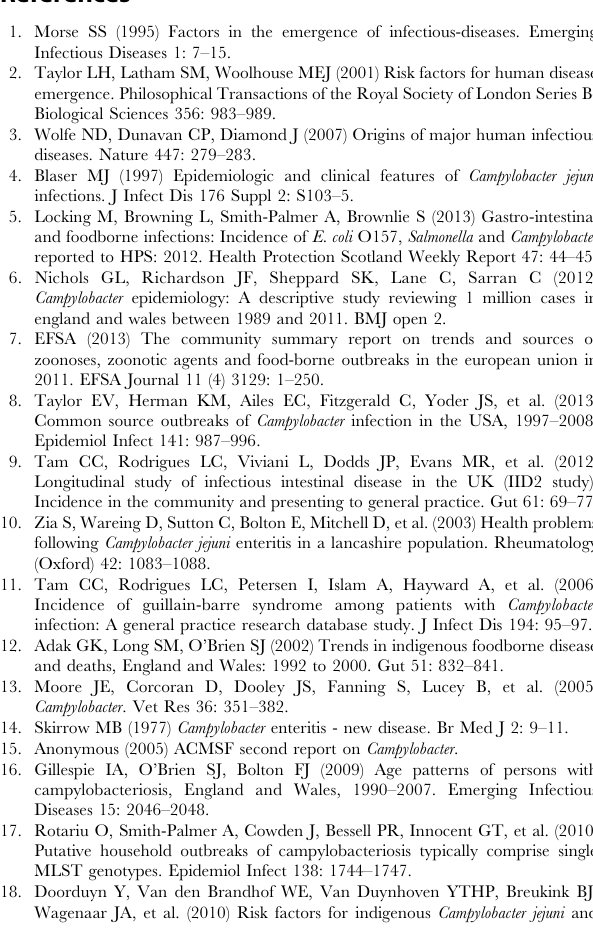
Table S1 Molecular typing data and analysis (clinical, animal/ food, attribution scores, genetic distance, common sequence types